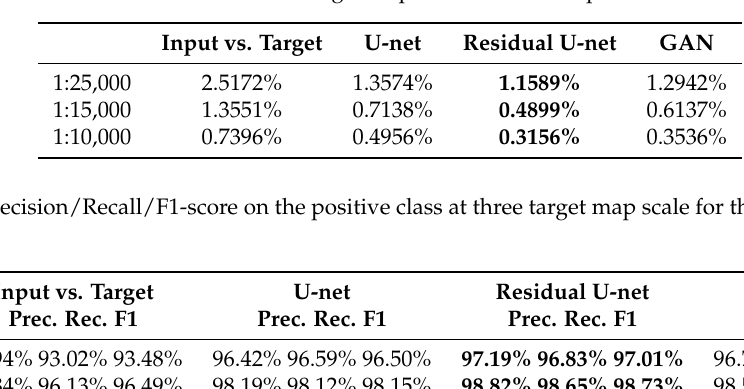
Table 1. Error rate at three target map scale for the independent test set.